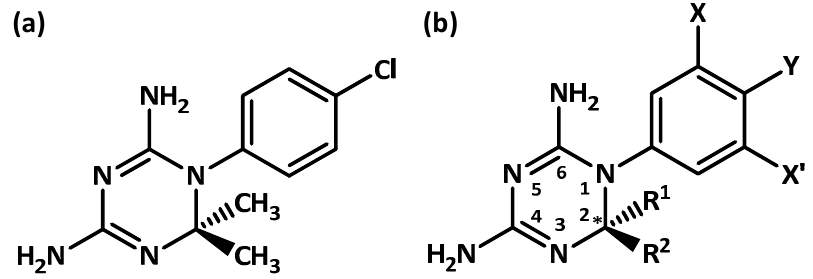
Figure 1. Chemical structure of ( a ) cycloguanil (Cyc) and ( b ) Cyc derivatives. Asterisk indicates chiral center. X and X’ are m- positions. Y is p- position.